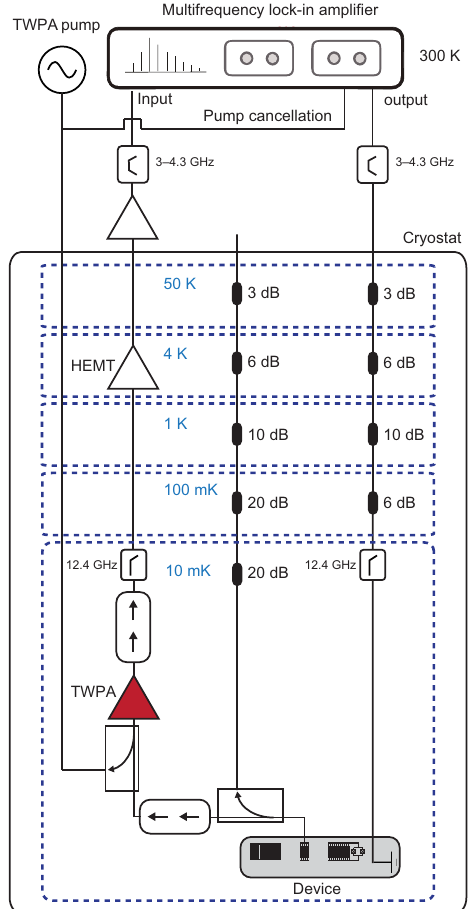
FIG. 6. Schematic of the measurement setup. The signal out- put and input have band-pass filters to suppress harmonics and spurious tones. To avoid cross talk from the flux pump line satu- rating the TWPA, we use a destructively interfering cancellation tone at the pump frequency. This cancellation tone, used only in the two-mode squeezing experiment, is output from a separate channel and combined with the TWPA pump. The input line to the IDT is used for characterizing the resonator